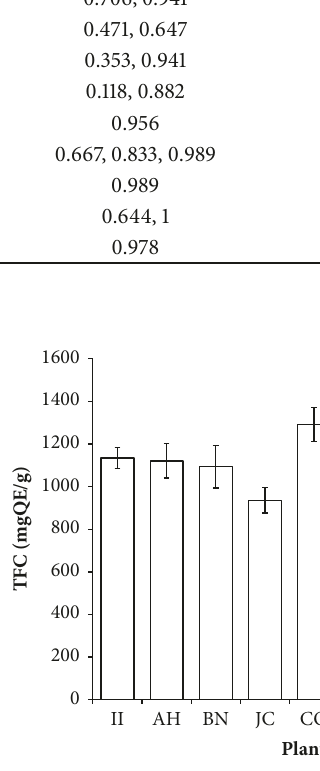
BNI, MM, CA, BA, EI, and BN had absorbance value of